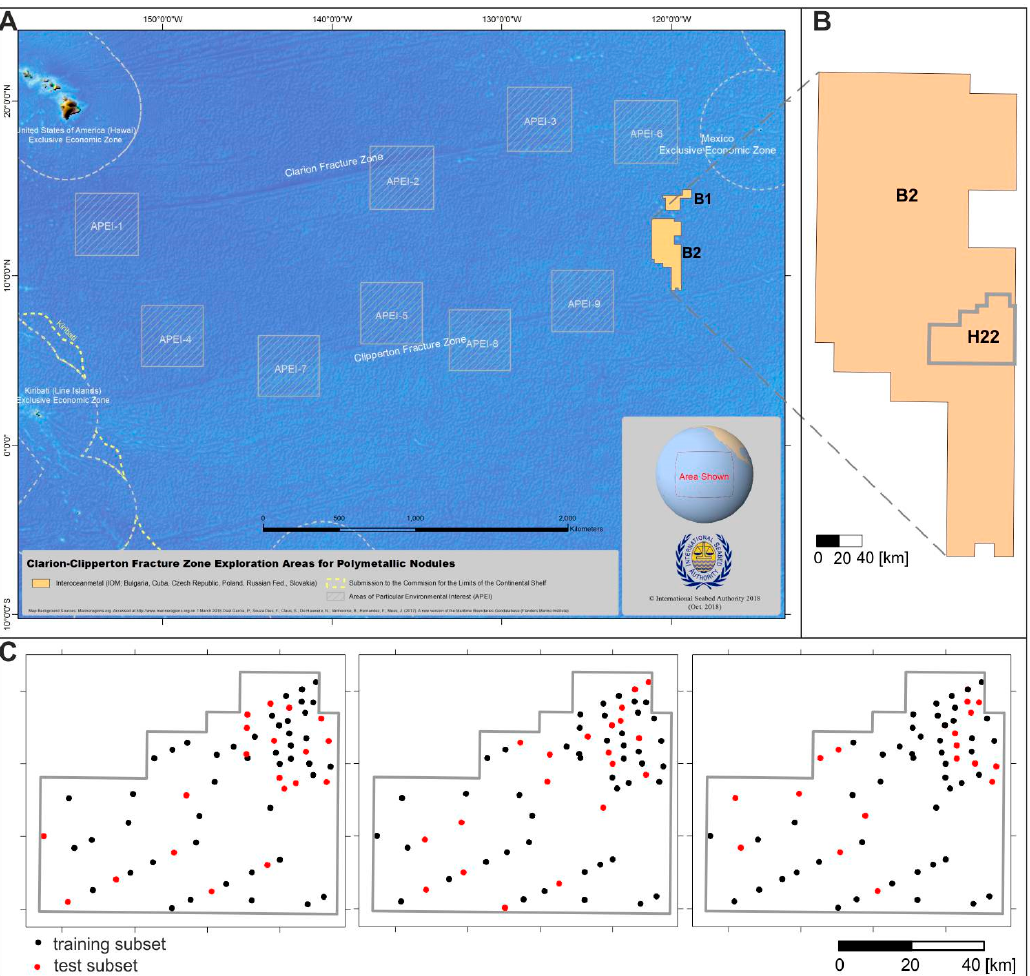
Figure 1. Location of B2 Interoceanmetal Joint Organization (IOM) exploration area for polymetallic nodules against the background of the Clarion–Clipperton zone [19] ( A ) and H22 exploration block ( B ); the location of the box corer sampling sites and seafloor photographs in the H22 exploration block (three variants of training and test subsets) ( C ).